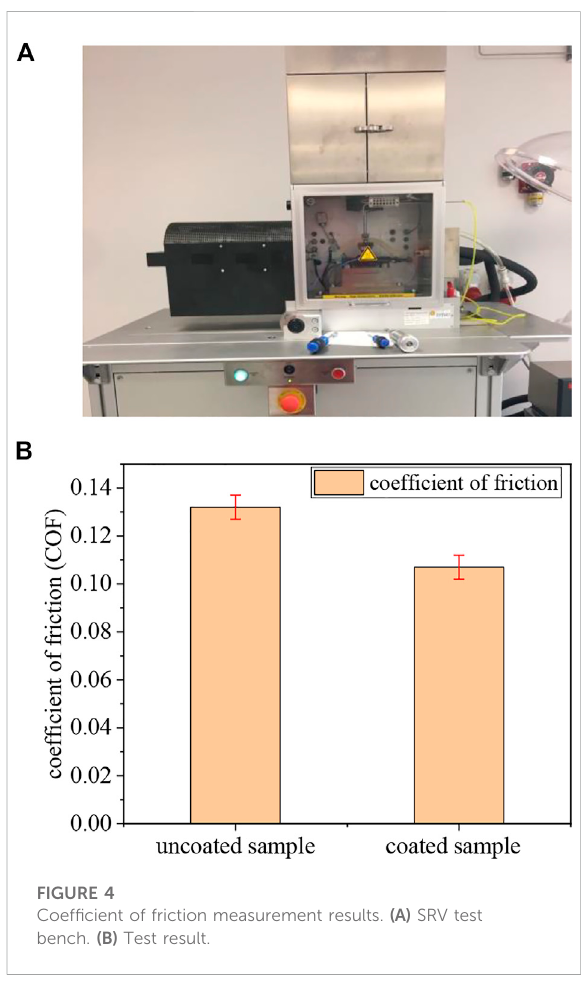
TABLE 2 Gear material parameters.